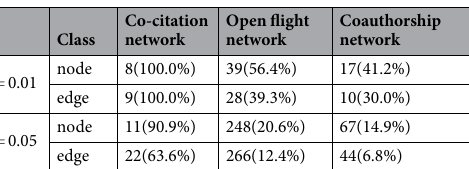
Table 4. Comparative results with overlap ratios of the Serrano backbone and